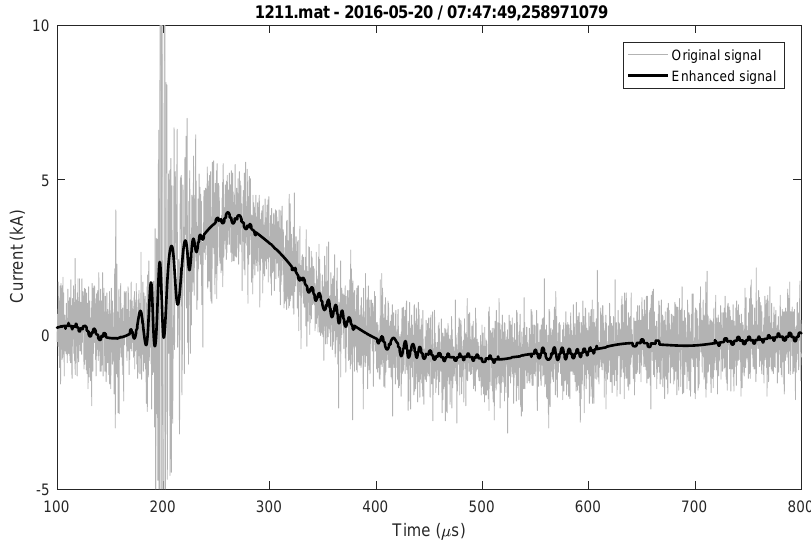
Figure 11. Positive lighting flash original and enhanced signal.